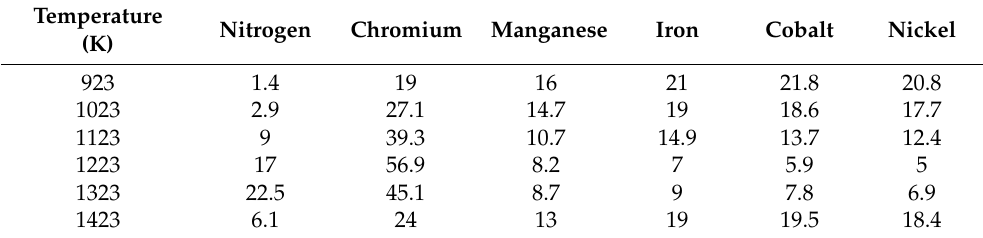
Table 3. EDS semi-quantitative chemical compositions, in atomic %, of sigma phase of cold-rolled samples. Relative uncertainty on data is less than 2% except for N (30%) and Mn